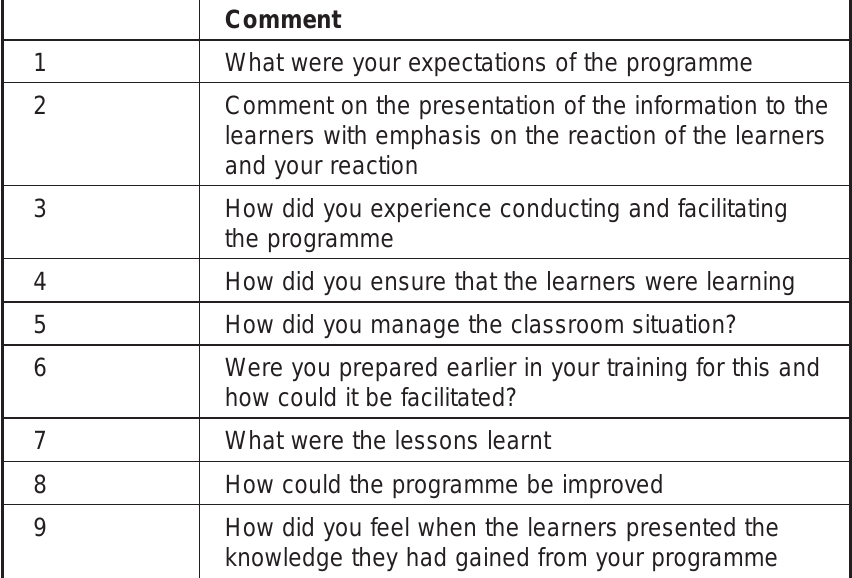
Table 2: Guiding questions for